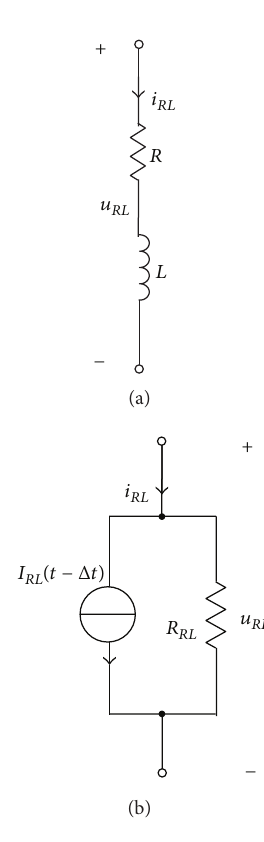
Figure 7: Discretization representation of capacitance. (a) Capaci- tance and (b) parallel circuit unit.